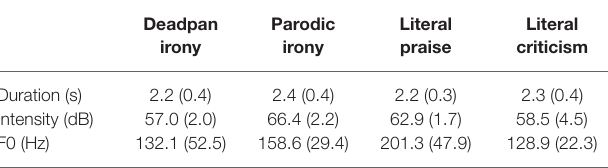
TABLE 2 | Acoustical analyses for different types of utterances: mean duration, mean intensity, and mean